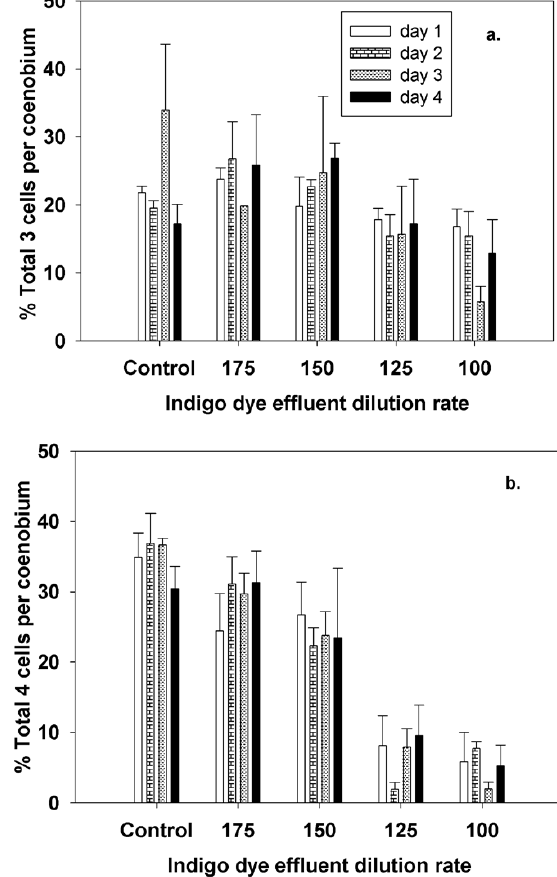
Fig. 4 - Percentage of total production of single cells (a) and 2 cells per coenobium (b) of Scenedesmus quadricauda exposed to different indigo dye effluent concentrations.